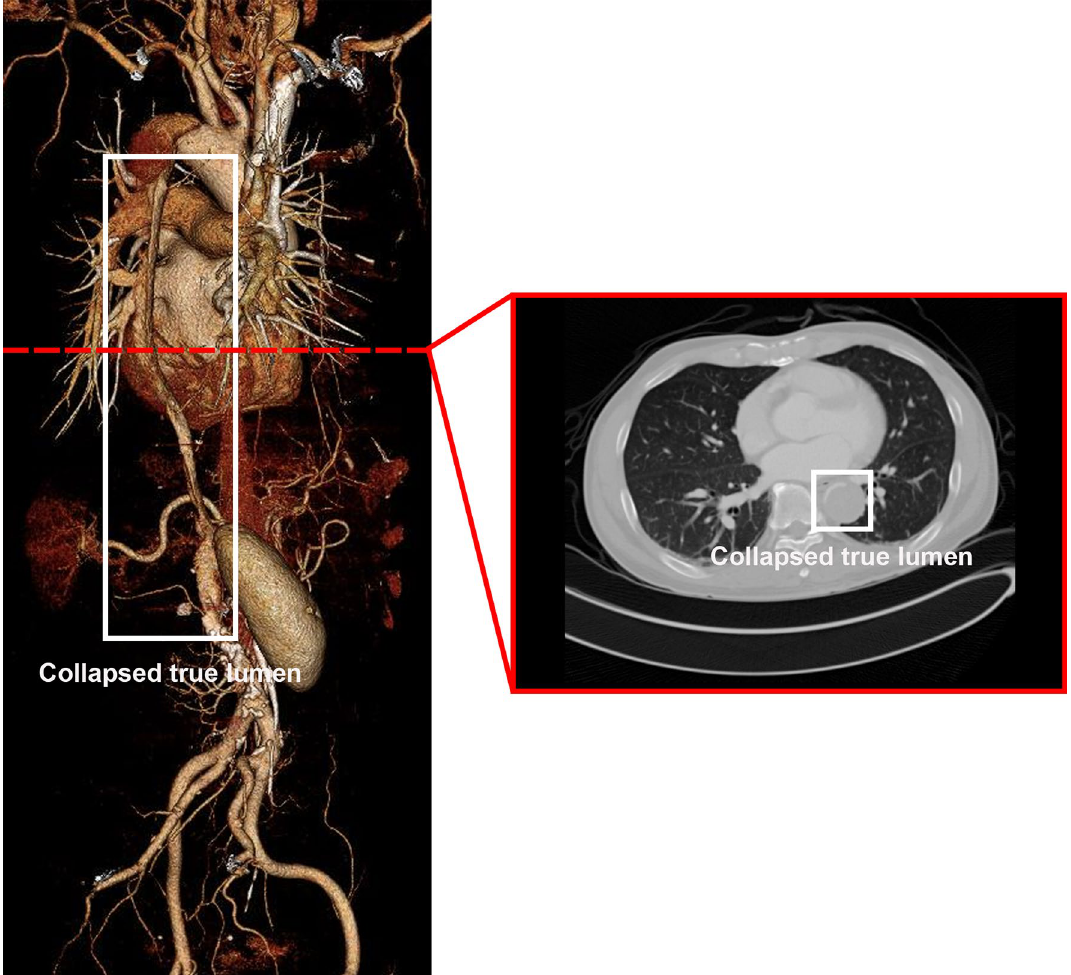
Figure 1. 3D volume rendering and axial view of computed tomography in an AD patient with lower extremities malperfusion due to true lumen collapse. The image was reconstructed using TeraRecon (https:// www. terar econ.